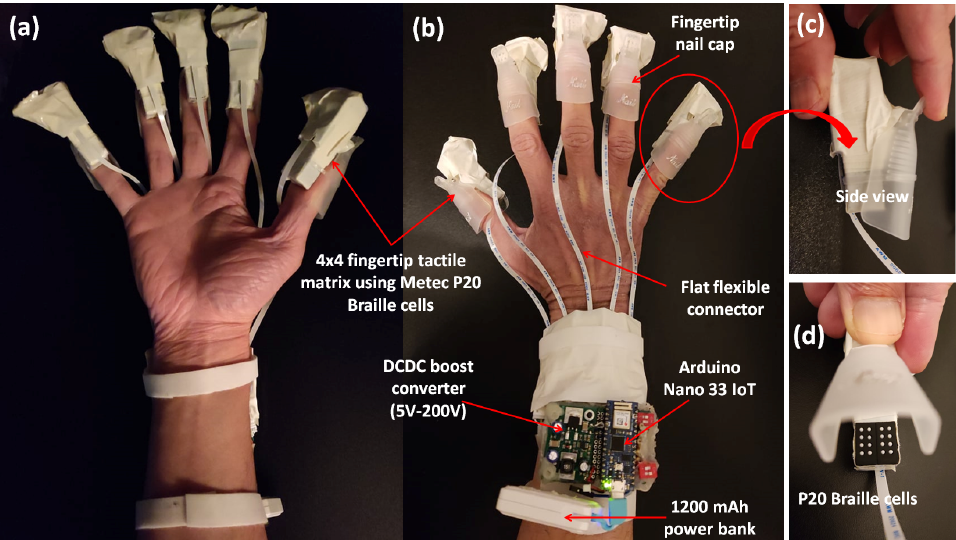
Figure 2. Untethered high-resolution haptic hand wearable having 80 tactile actuators (tactors). There is a 4 × 4 matrix of tactors on each fingertip made from Metec P20 Braille cells. The prototype has an open-backhand and open-palm design for easy hand tracking. ( a ) Open-palm view, ( b ) open- backhand view, ( c ) side view of the fingertip tactile matrix with an invisible rubber band to increase the grip of the nail clip if the user has a small or thin finger, and ( d ) 4 × 4 fingertip tactile matrix made from two P20 Braille